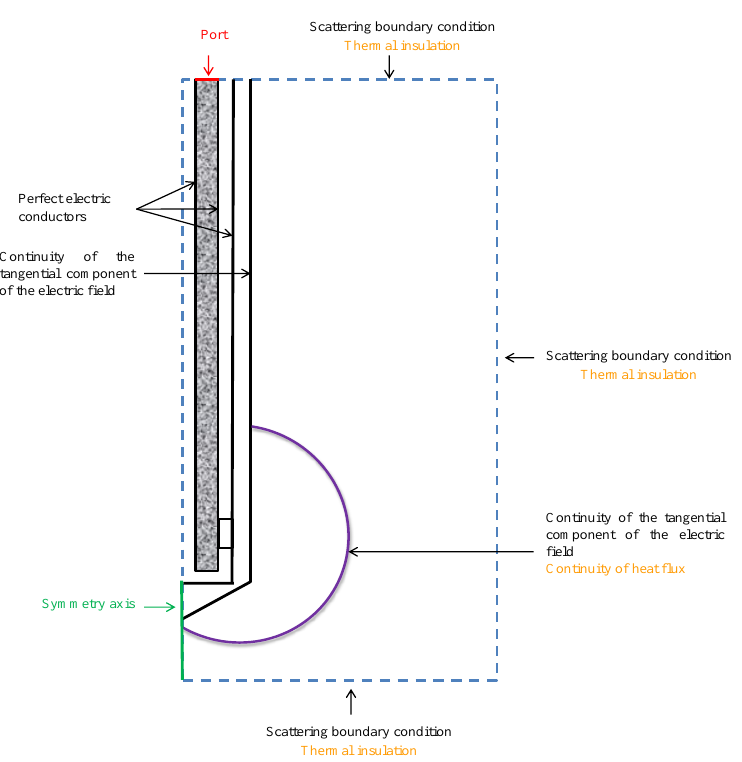
Figure 4. Boundary conditions used for the simulation.